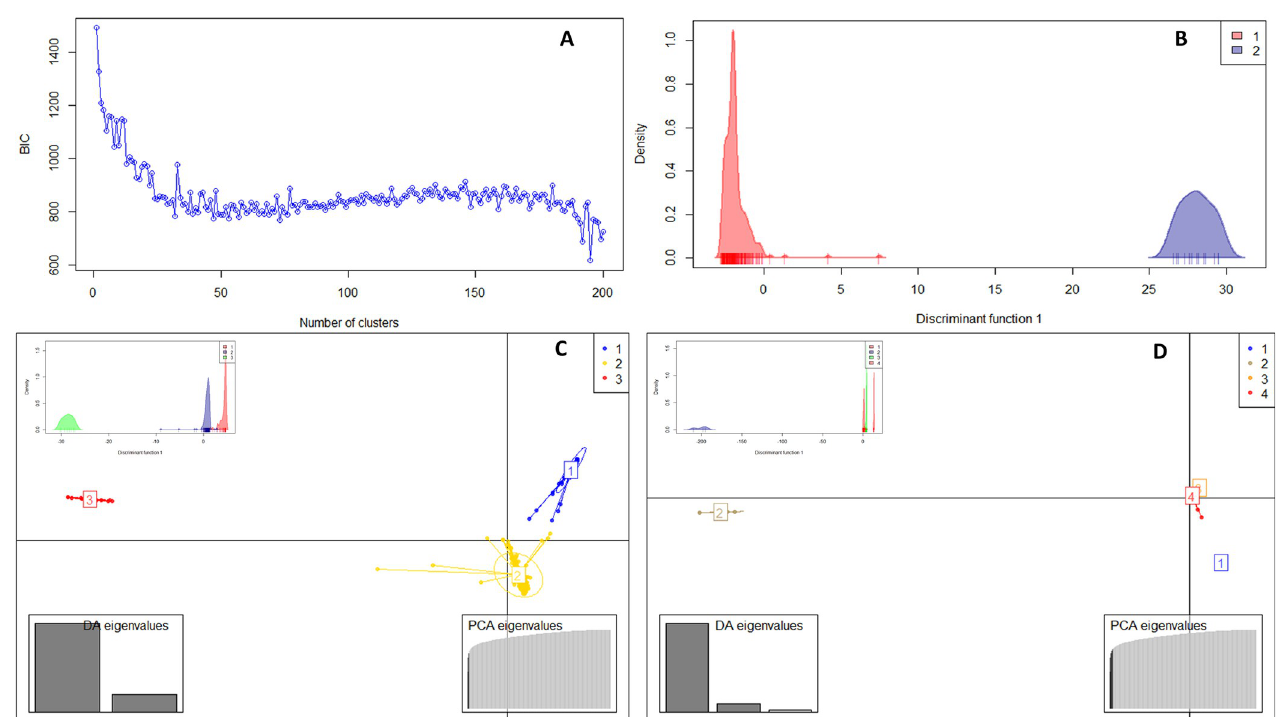
Fig 6. Discriminant analysis of principal components (DAPC). (A) The graph of Bayesian information criterion (BIC) vs. the number of clusters indicates the optimum number of clusters inferred in the yam diversity panel; (B) Discriminant analysis of principal components with K = 2; (C) Discriminant analysis of principal components with K = 3; (D) Discriminant analysis of principal components with K = 4. The axes represent the first two linear discriminants. Each colour represents a cluster and each does represent an individual.